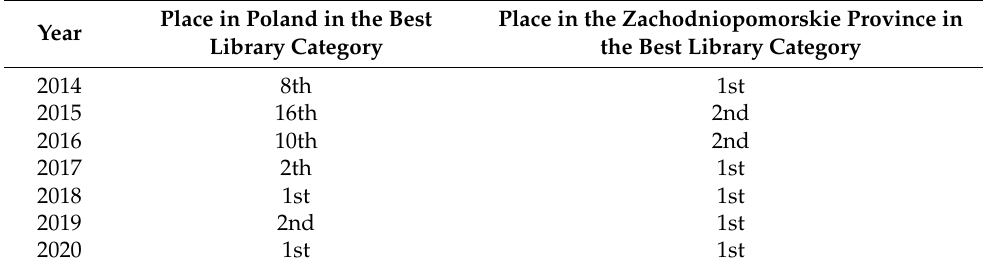
Table 10. Sian ó w library’s places in the 2014–2020 Ranking of Libraries. Place in Poland in the Best Place in the Zachodniopomorskie Province in Library Category the Best Library